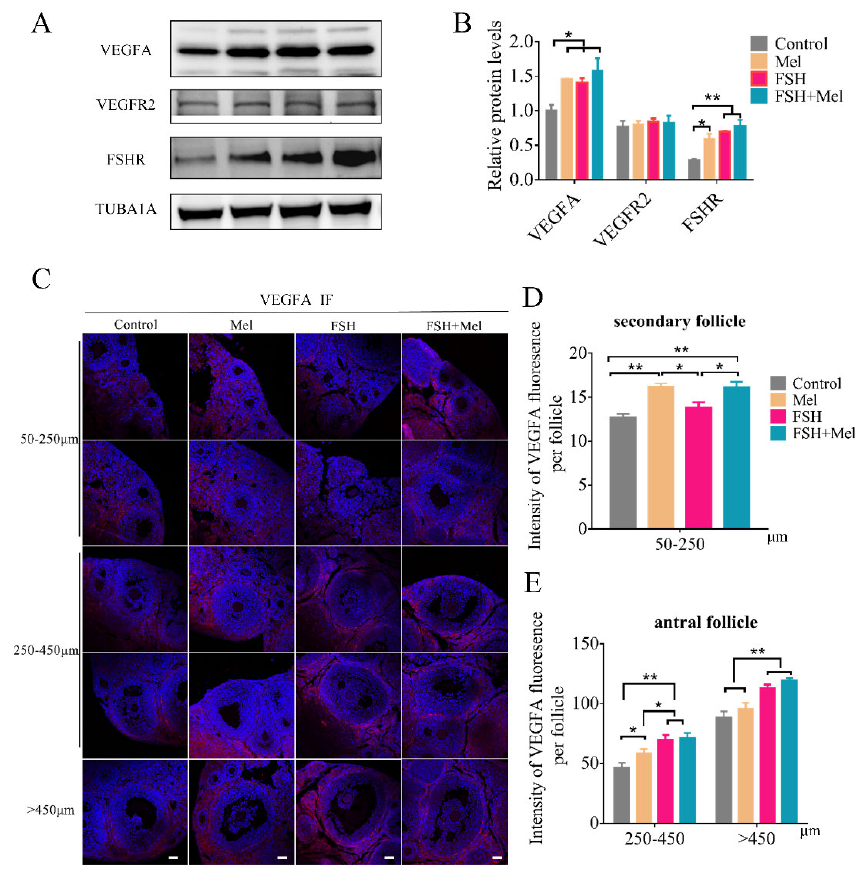
Figure 3. Effect of Mel on the expression of VEGFA. ( A ) Western blotting detection of VEGFA, VEGFR2, FSHR protein expression level in ovary. ( B ) Quantification analysis of the VEGFA, VEGFR2, FSHR protein expression level. ( C ) Immunofluorescence (IF) detection of VEGFA expression level in follicles at all stages. ( D ) Quantification analysis of the VEGFA expression level in 50–250 µ m follicles. ( E ) Quantification analysis of the VEGFA expression level in 250–450 µ m and >450 µ m follicles. Horizontal bars denote treatments differing p < 0.05 *, p < 0.01